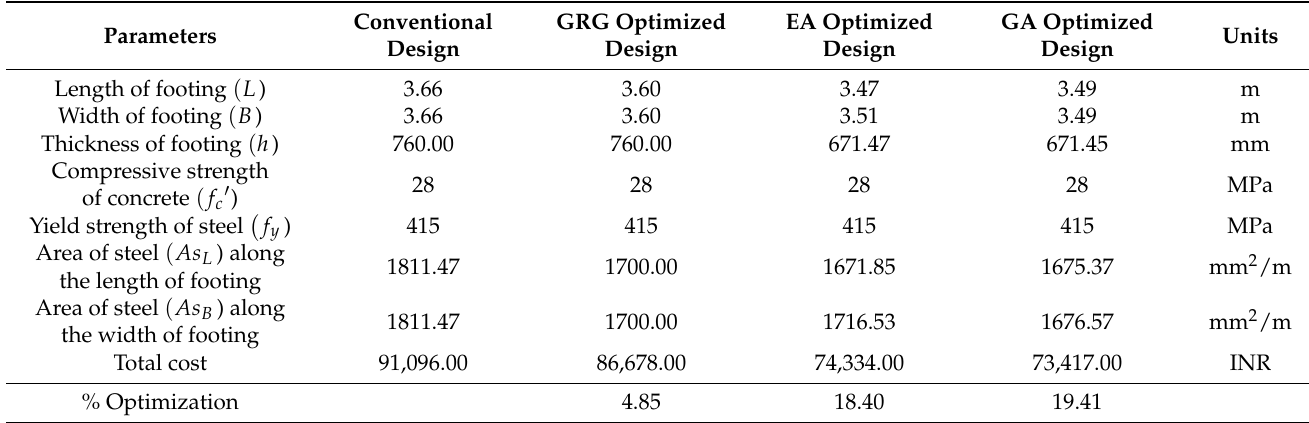
Table 6. Optimum values obtained for example